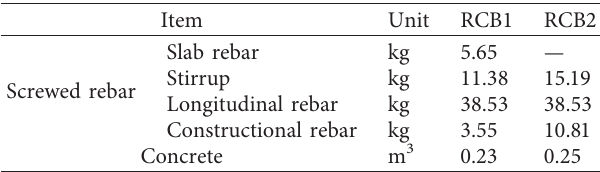
Table 6: Quantity survey of RCBs.